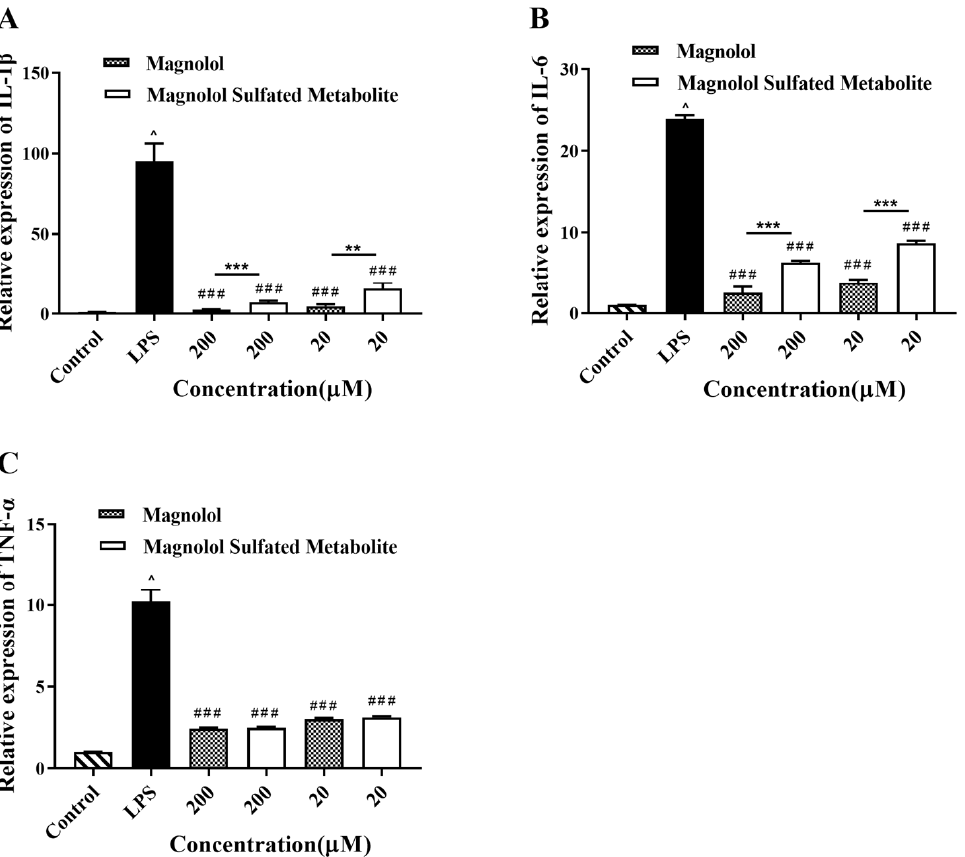
Figure 8. The effect of magnolol and its sulfated metabolite on the expression of IL-1 β ( A ), IL-6 ( B ), and TNF- α ( C ) in LPS- stimulated RAW264.7 cells. Each data represents an average of four determinations, and the error bar is the standard deviation of the mean. ˆ p < 0.05 vs. control. ### p < 0.001 vs. LPS group. ** p < 0.01, *** p < 0.001 vs. the magnolol group.